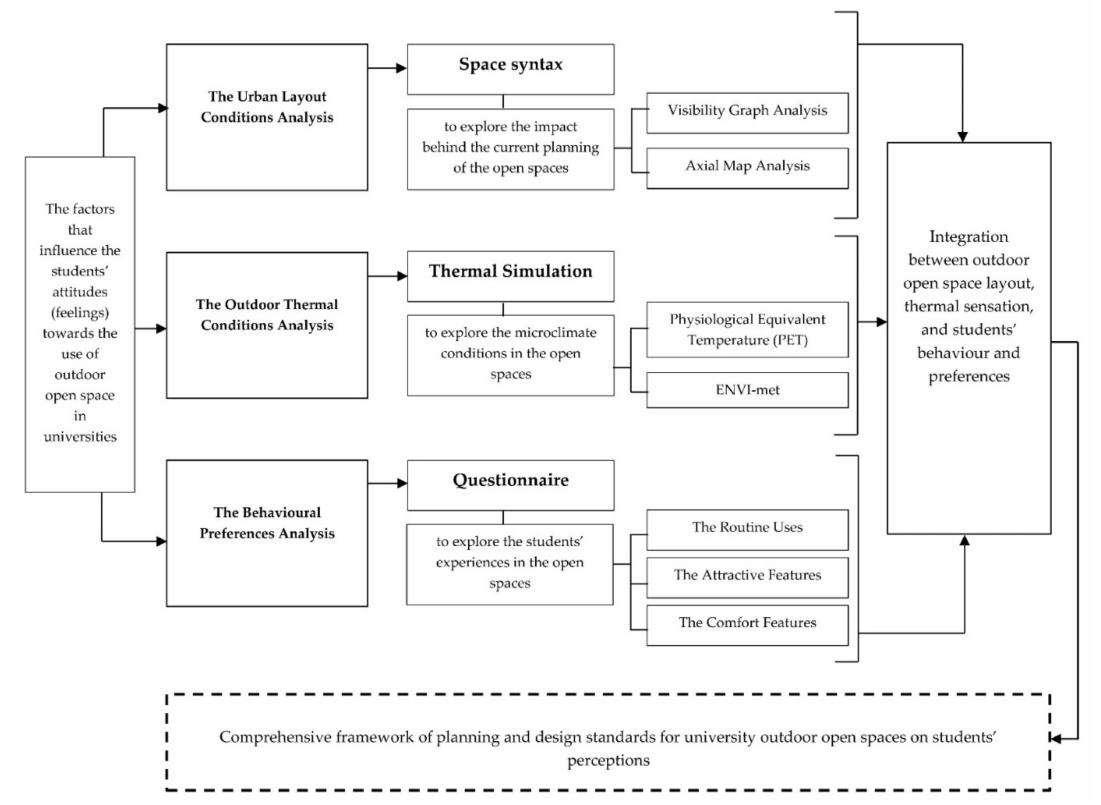
Figure 1. Research design: methods and